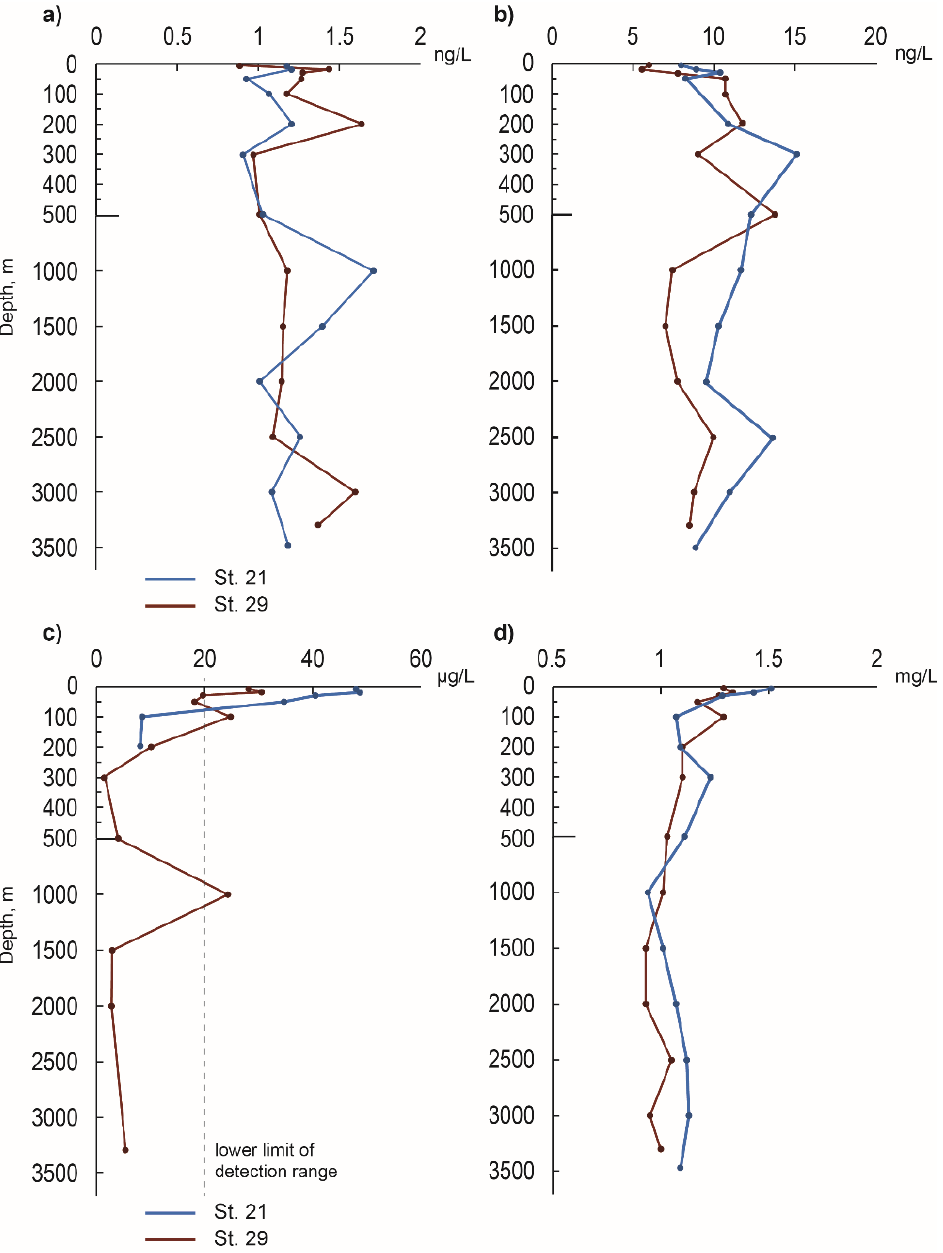
Figure 4. The deep water profiles of ( a ) ∑ 8 PPAHs; ( b ) ∑ 9 DPAHs; ( c ) POC and ( d ) DOC in the Japan Basin. POC at St.21 was not detected below the depth 200 m.